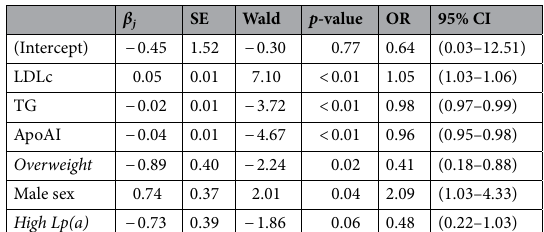
Table 2. Final model fit for LR model. SE standard error, OR odds ratio, CI confidence interval, LDLc low density lipoprotein cholesterol, TG triglycerides, Apo apolipoprotein, Lp(a) Lipoprotein(a).